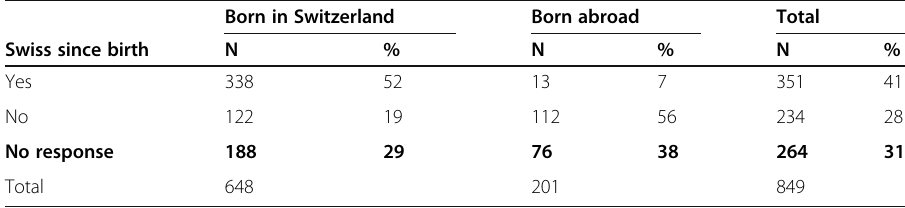
Table 5 Cross-tabulation, place of and nationality at birth Born in